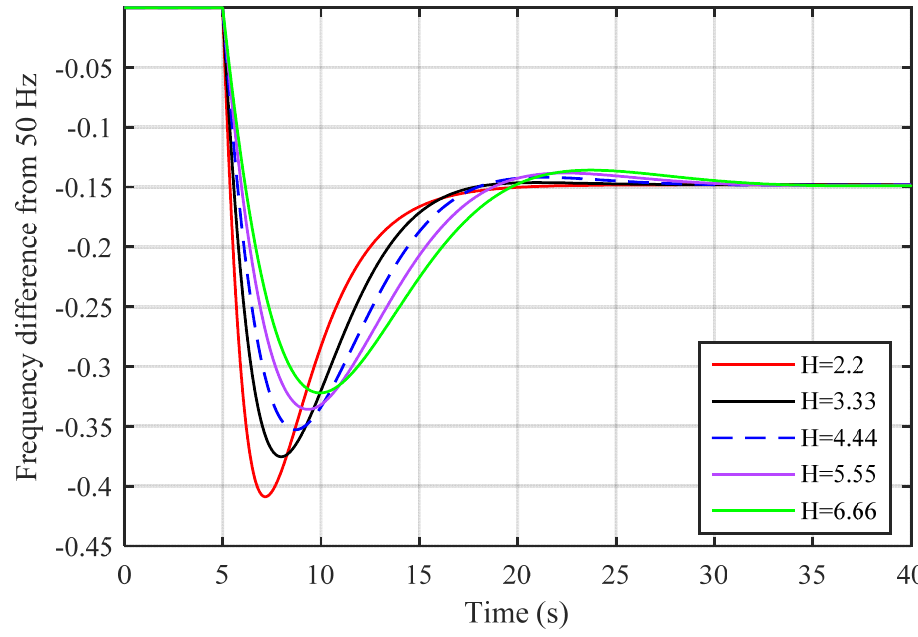
Figure A3. The primary frequency response of GB power system with various values of H.